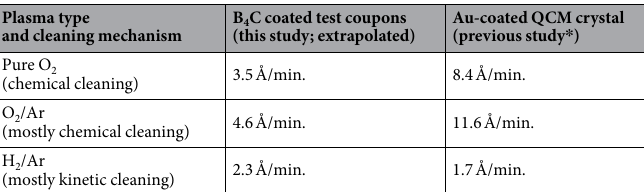
Plasma type and cleaning mechanism